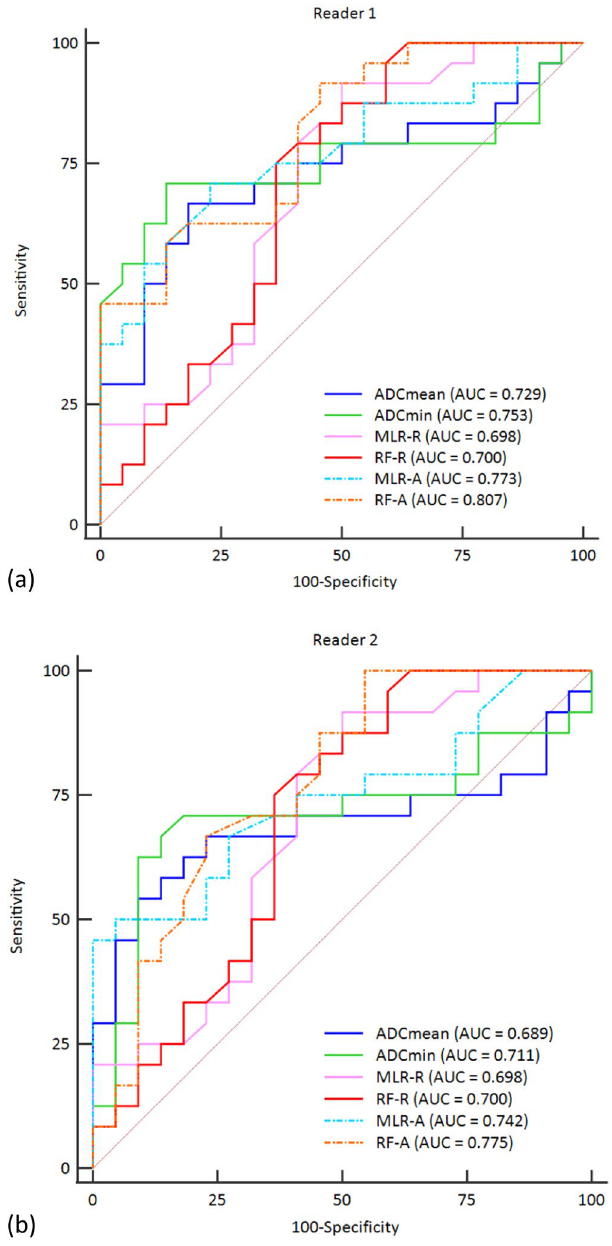
Figure 2. Comparison between the diagnostic performance of ADC values and 4 radiomics models (MLR- R, RF-R, MLR-A and RF-A) in reader 1 ( a ) and reader 2 ( b ). The plots were generated using MedCalc for Windows, version 19.0 (MedCalc Software, Ostend,